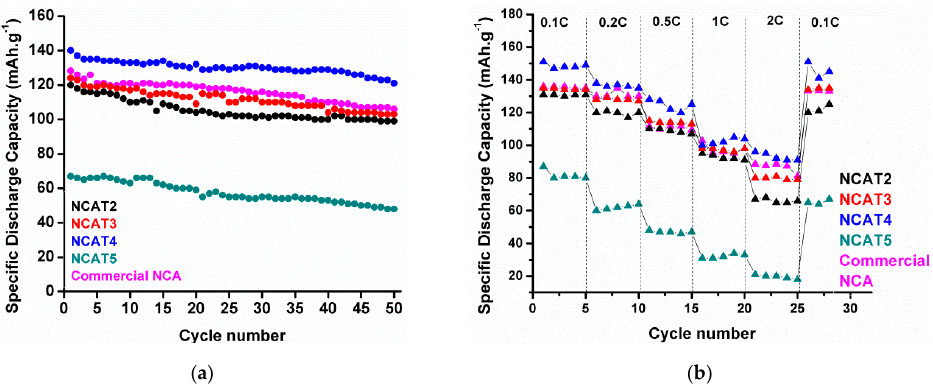
Figure 13. ( a ) Cycle performance and ( b ) rate-ability of as-prepared NCA at varying sintering temperature.